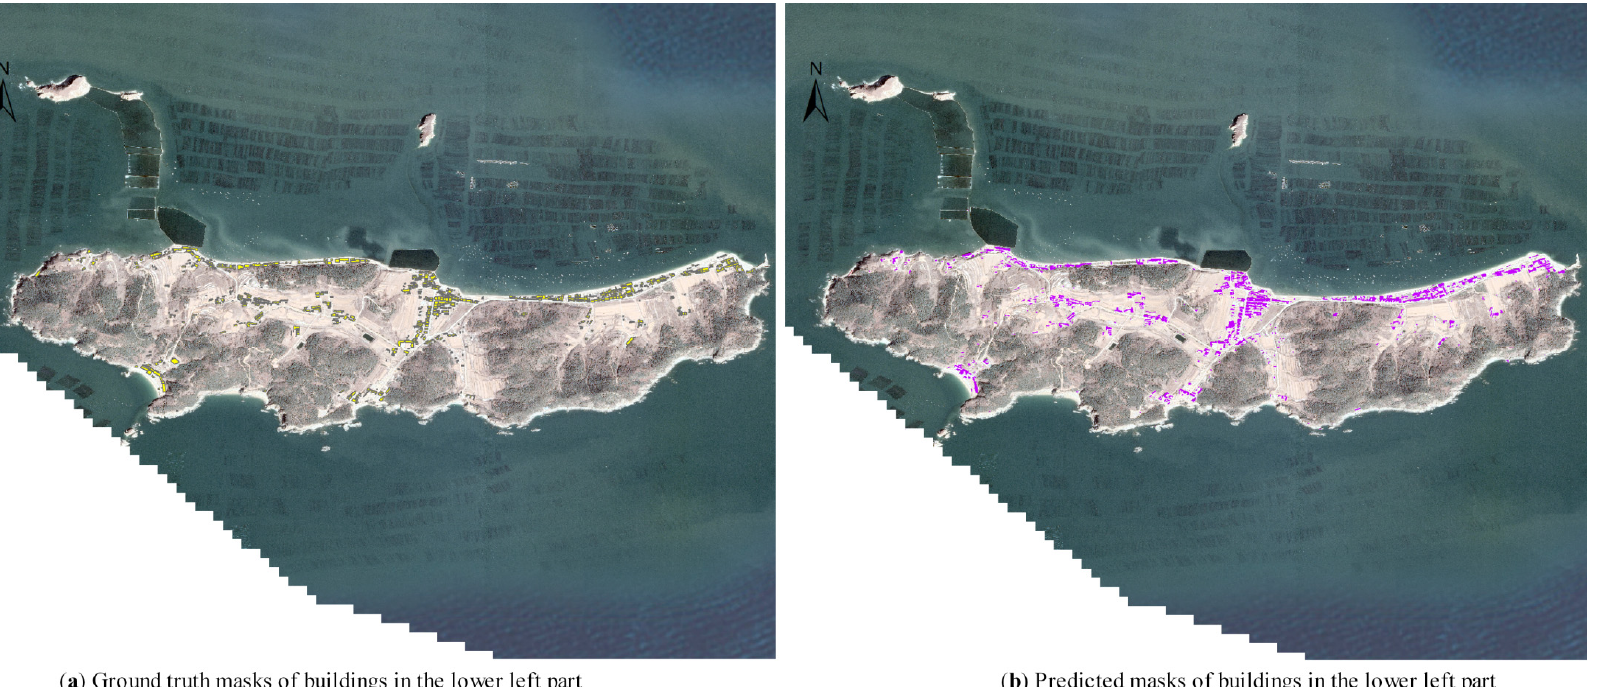
Figure 11. Ground truth mask ( a ) vs. predicted mask ( b ) of the buildings for the lower left part of the test area.